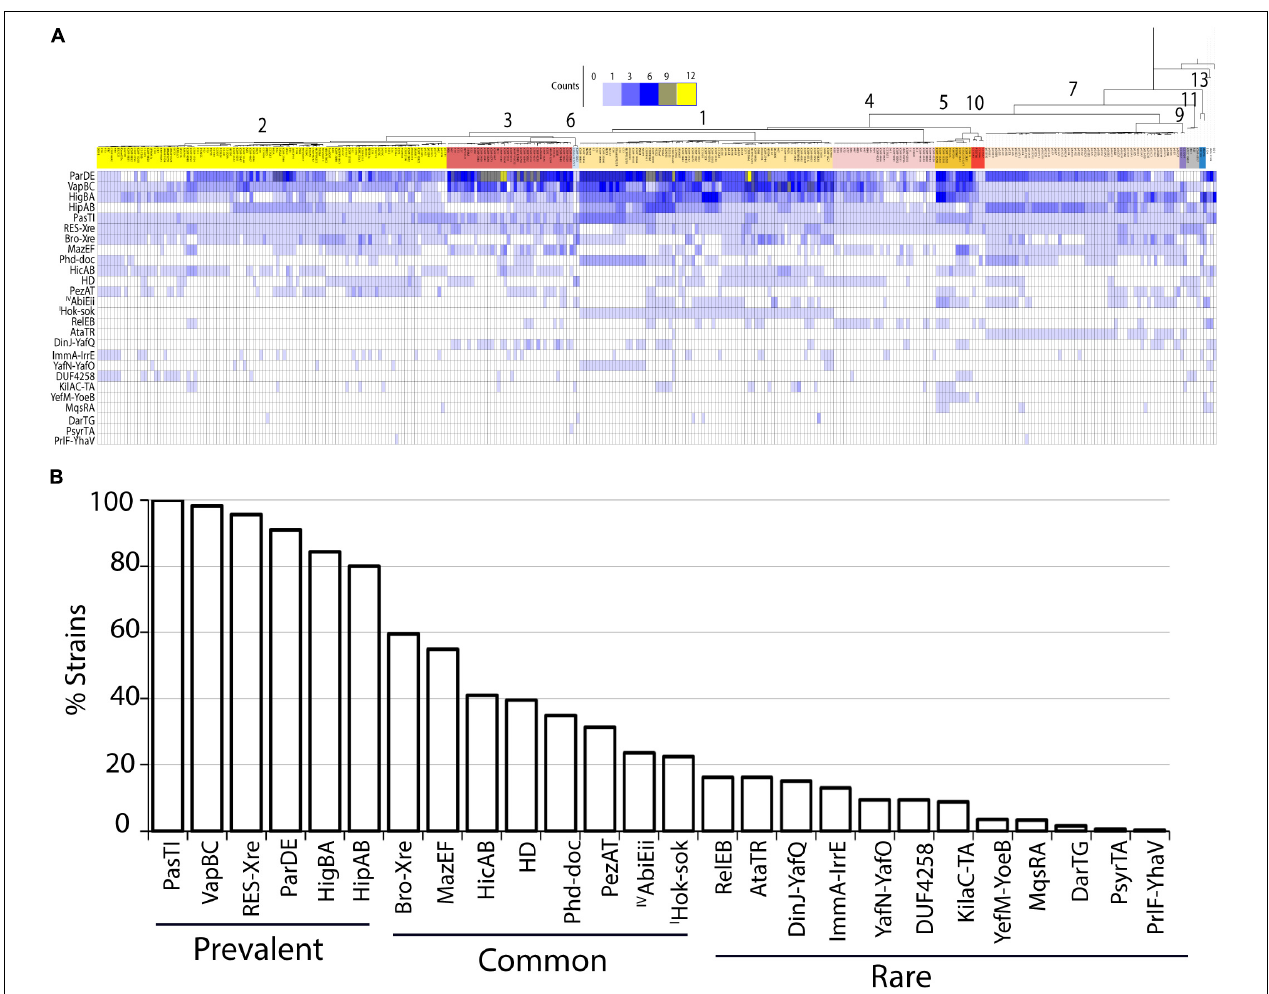
FIGURE 1 | (A) Heatmap showing TA system content and distribution across P. syringae species complex. Names of TA systems are indicated for each row. Number of homologs of each TA systems are indicated by the color key at the top. Phylogenetic tree color coded according to phylogroups are indicated by numerals. (B) Percentage of strains containing the TA systems. List of all the TA systems found in P. syringae are shown in the x-axis, and the fraction of strains carrying a given TA system out of the 339 strains is shown in the y-axis. TA systems were categorized as prevalent, common, and rare based on their abundance as shown. Except abiEii (type IV), and hok-sok (type I) all belong to type II TA